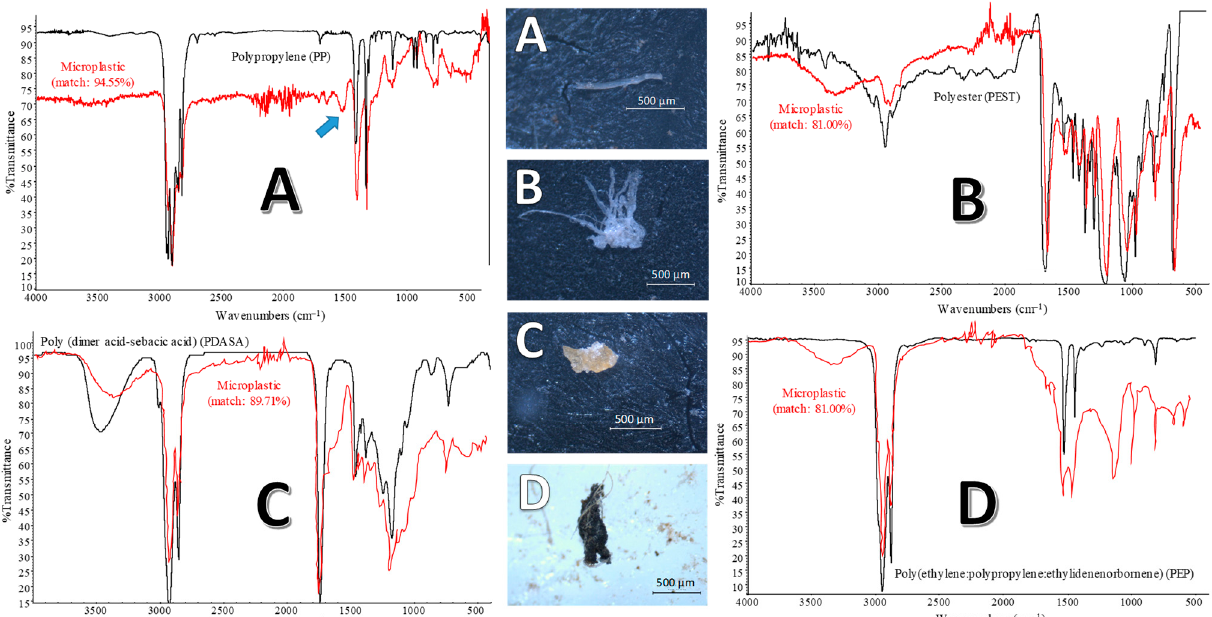
Figure 6. Infrared standard spectra (black) and microplastics (red) for: ( A ) Polypropylene (HDPE) INF 24 May 2020 (94.55%) (Polymer Additives and Plasticizers); ( B ) Polyester (PEST) INF 19 September 2019 (81.00%) (Synthetic Fibers by Microscope); ( C ) Poly (dimer acid-sebacic acid) copolymer (PDASA) INF 20 March 2019 (89.71%) (Polymer Additives and Plasticizers); ( D ) Poly (ethylene:propylene:ethylidene norbornene) (PEP) INF 28 February 2019 (81.00%) (Hummel Polymer and Additives).